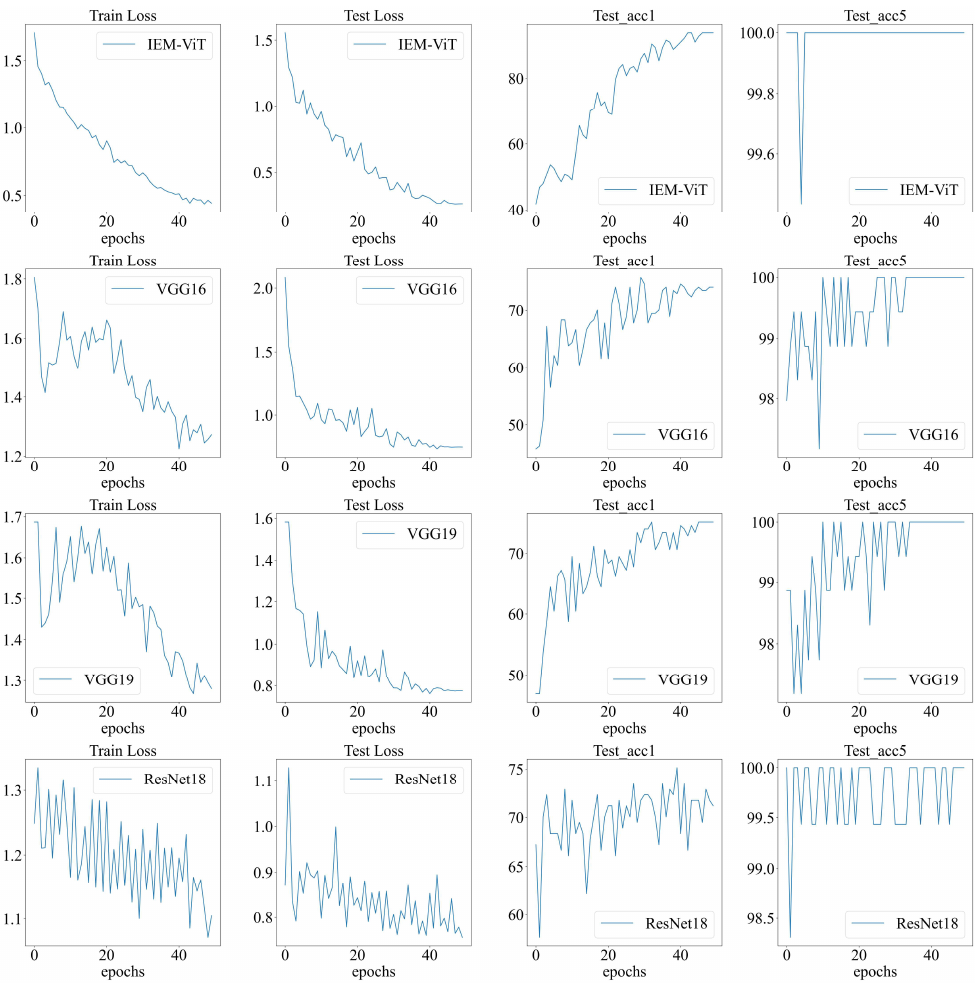
Figure 8. Loss and accuracy of each model.